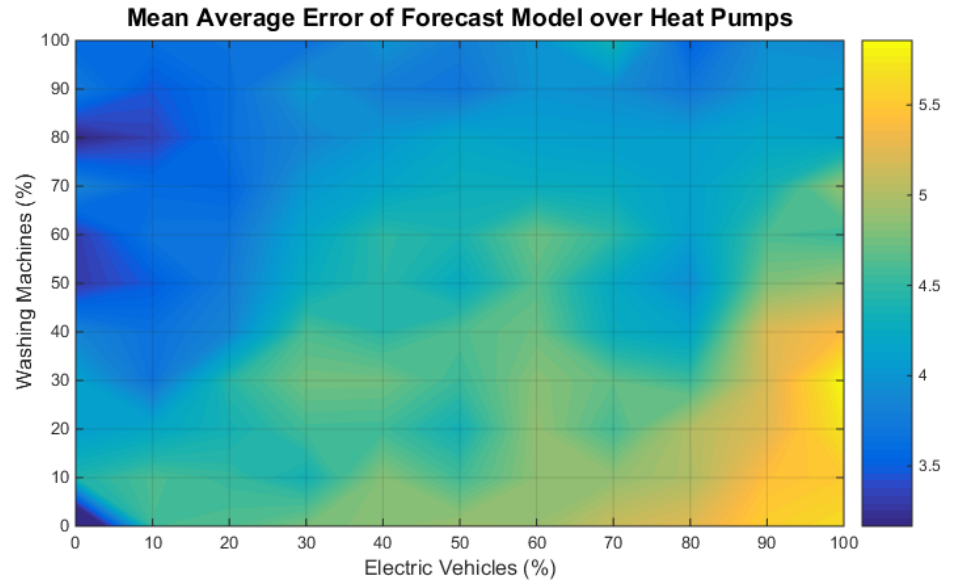
Figure 7. Mean average error of the forecasting model for each virtual power plant (VPP) when the penetration of EV and washing machines is varied. Each VPP composition’s error is the result of averaging the MAE over a varying number of heat pumps.